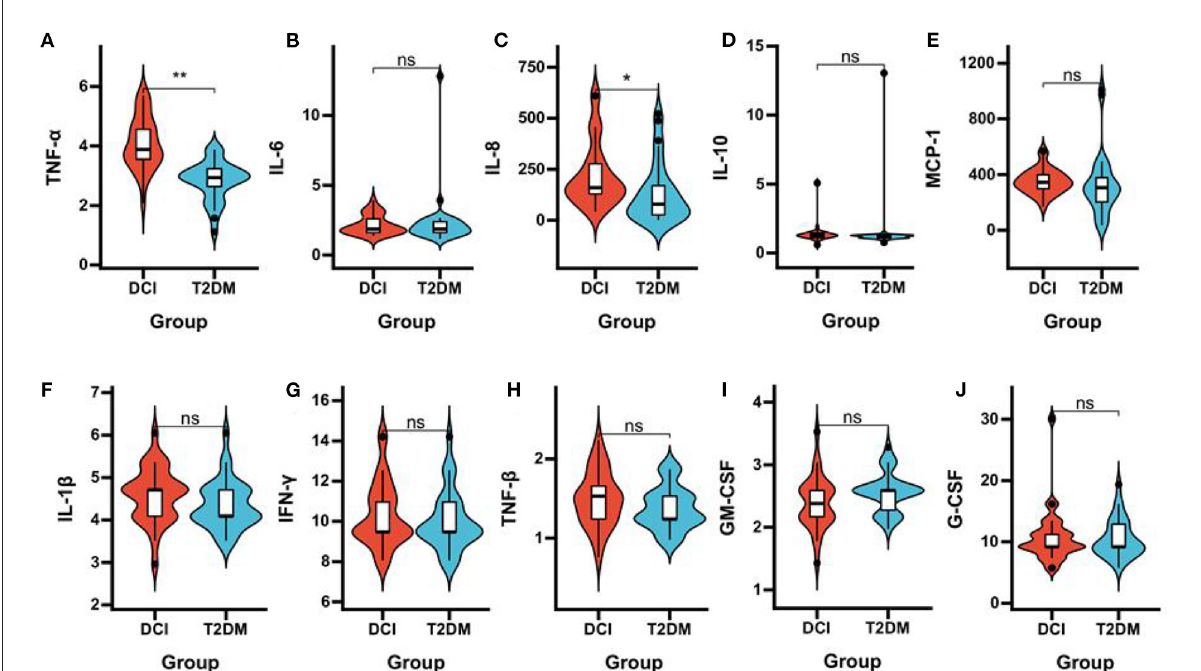
FIGURE4 Comparison of the plasma concentrations of inflammatory cytokines in DCI and T2DM groups. Violin plot showing data density and median with interquartile range for plasma concentrations of TNF- α (A) , IL-6 (B) , IL-8 (C) , IL-10 (D) , MCP-1 (E) , IL-1 β (F) , IFN- γ (G) , TNF- β (H) , GM-CSF (I) , G-CSF (J) in DCI and T2DM groups. * P < 0.05, ** P <